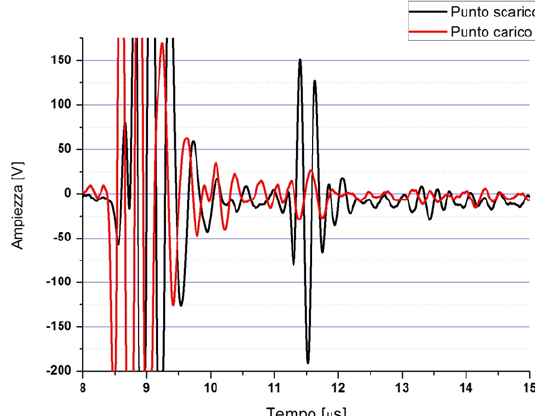
Figura 13: Onda riflessa acquisita in assenza e in presenza di carico. Figure 13: Reflected wave acquired without (black) and with load